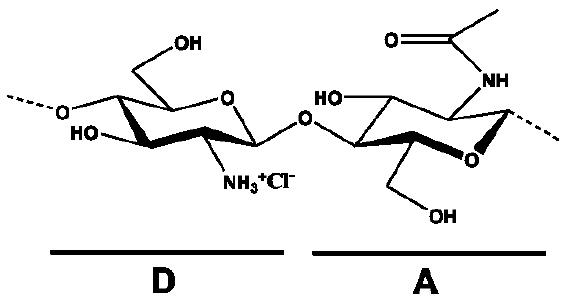
Figure 1. Schematic structure of chitosan: glucosamine (D) and N -acetyl-glucosamine (A) units.